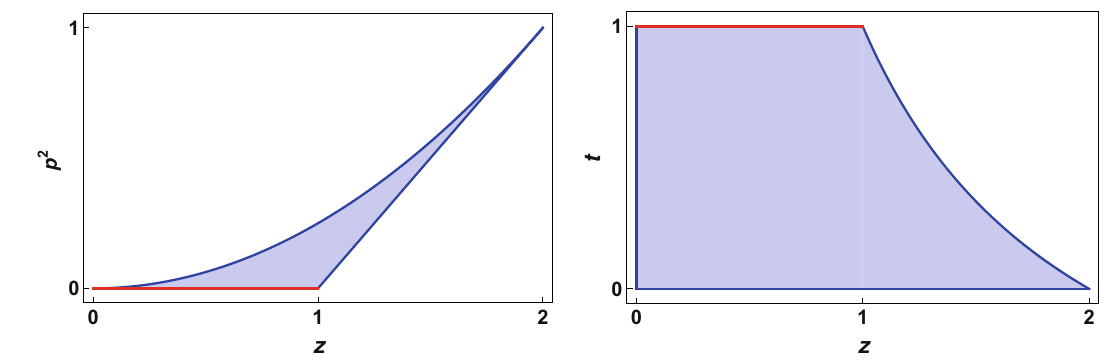
Fig. 1 Physical phase space regions in the z , ˆ p 2 plane (left panel) and z , t plane (right panel). In both cases, the line corresponding to tree level kinematics is indicated in